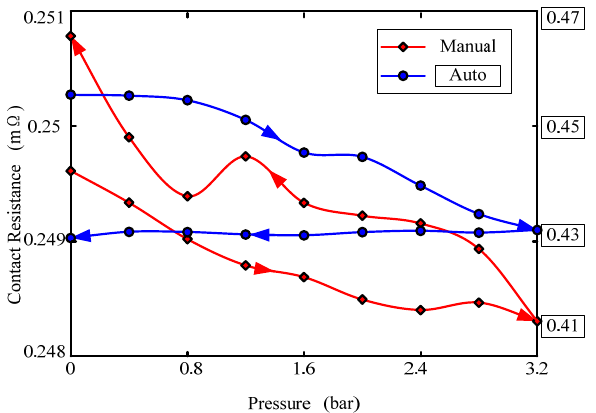
Figure 6. Contact resistance variations with pressure.